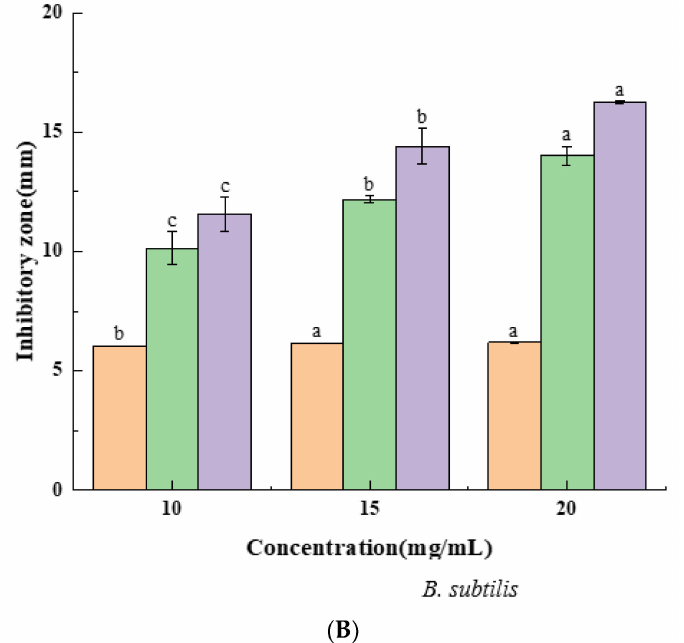
Figure 5. Minimum inhibitory concentration (MIC) of CS and phenolic acid-CS ( A ); inhibitory zone of CS and phenolic acid-CS ( B ). Different lowercase letters in the same column indicate significant differences ( p < 0.05).